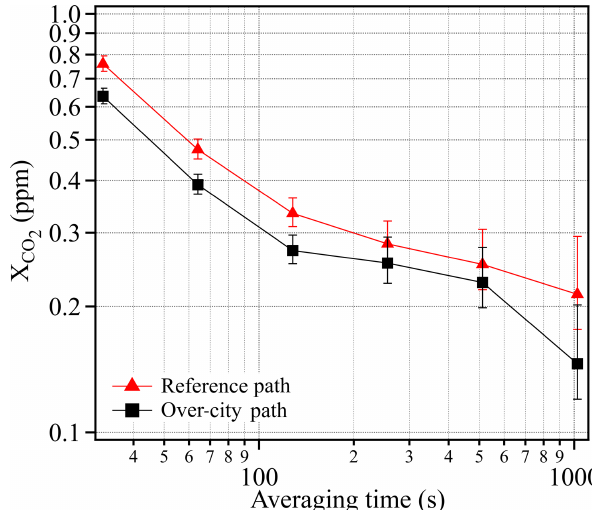
Figure 3. Statistical uncertainty as quantified by the Allan devia- tions for X CO over both the reference path (red triangles) and city 2 path (black squares) from a well-mixed 3h time period on the night of 3 October